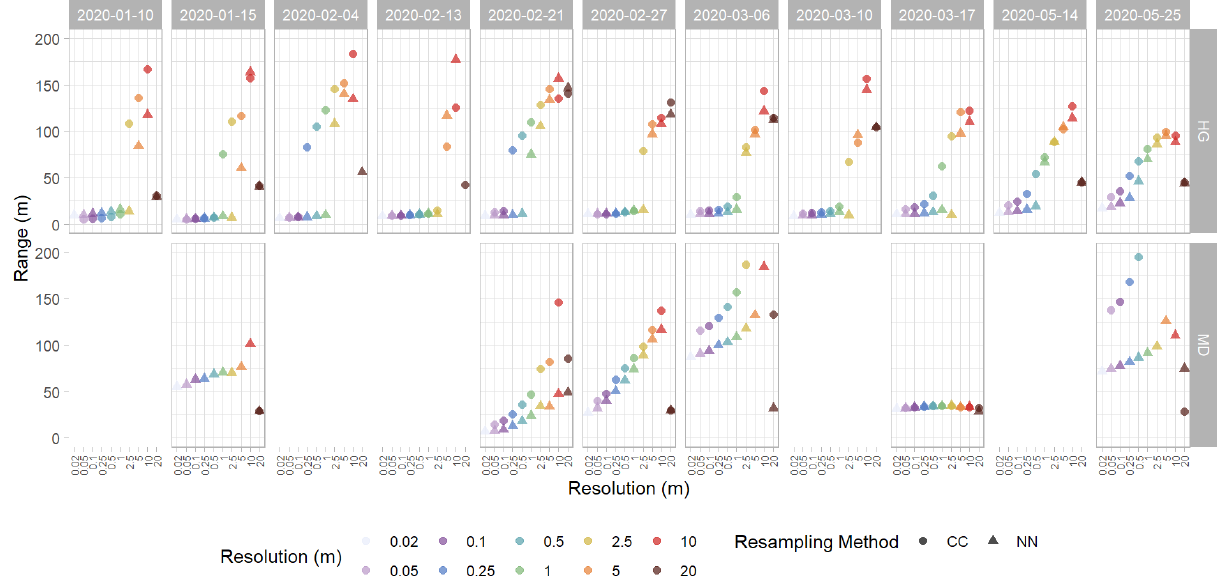
Figure A5. Range values from spherically fit variograms of detrended snow depth residuals from the Hourglass (HG) and the meadow (MD). Each panel depicts a specific observation day, with circles representing cubic-convolution (CC) resampling methods, triangles representing nearest-neighbor (NN) resampling methods, and colors representing different snow depth DSM resolutions. Five observation days were removed from the meadow site time series due to poor model